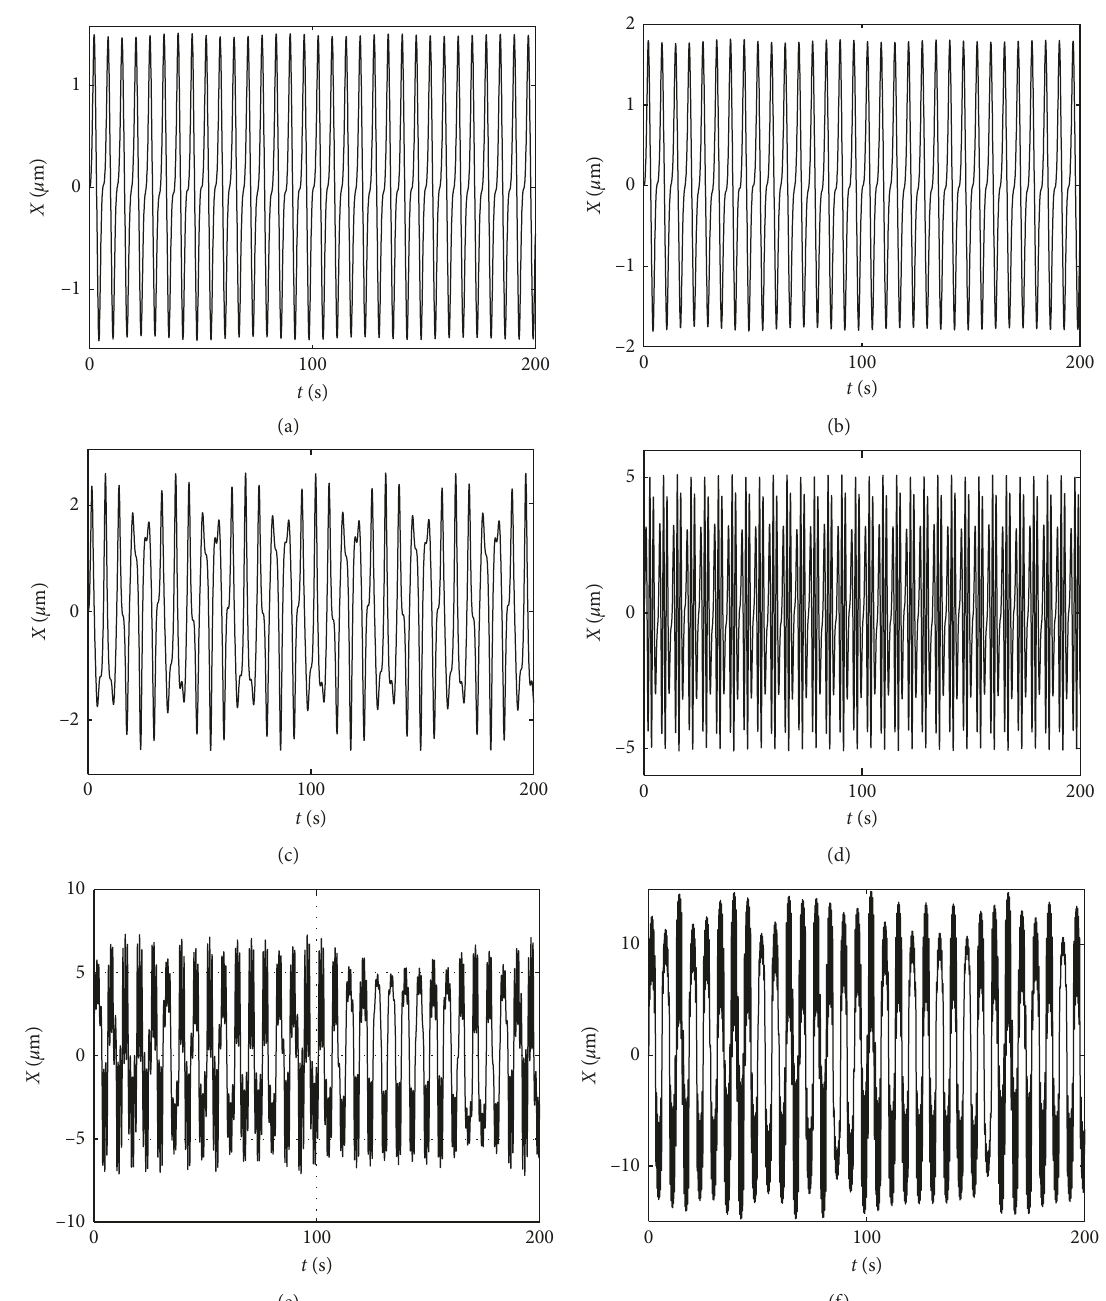
Figure 9: Wave diagram of displacement. (a) P � 20, (b) P � 100, (c) P � 260, (d) P � 450, (e) P � 600, and (f) P �